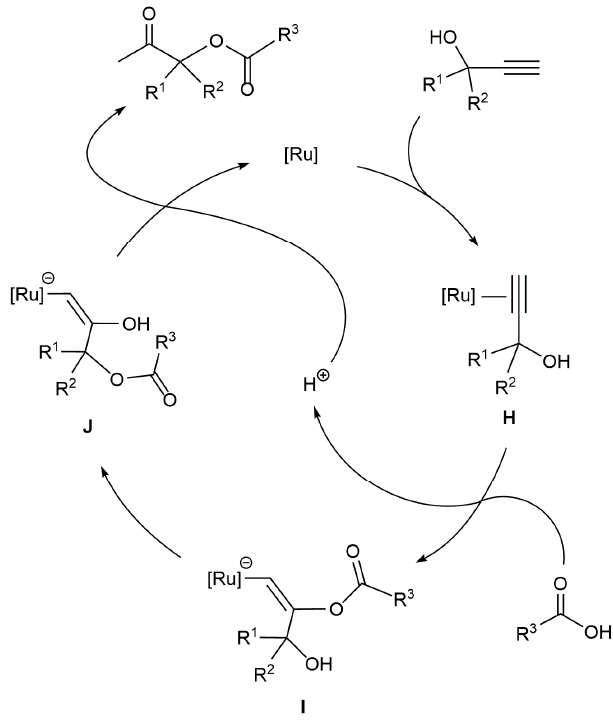
Scheme 23. Mechanism of the Ru-catalyzed β -oxo esters formation reactions.